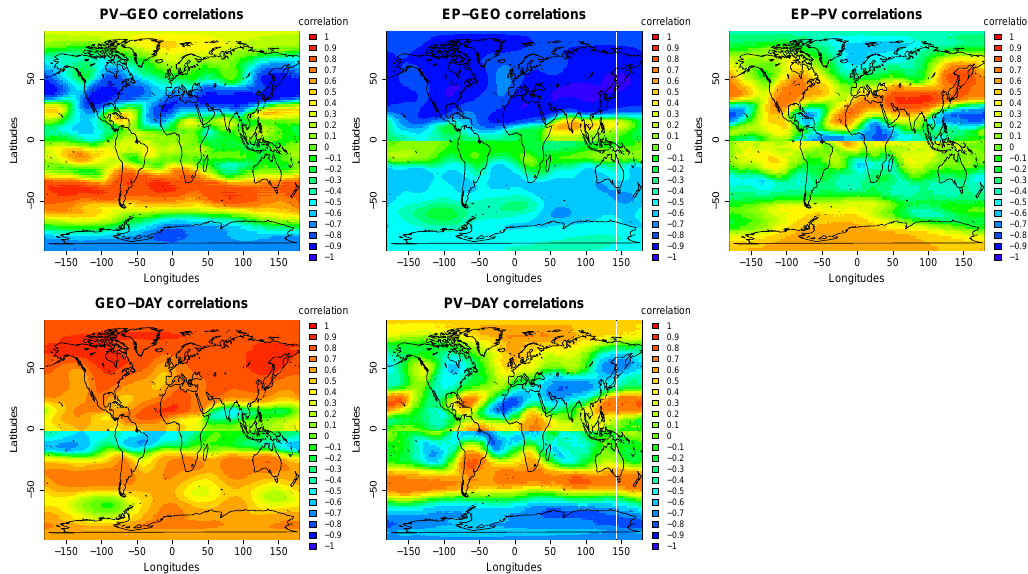
Figure 2. Correlation values between EP, GEO, PV and DAY. The correlations between EP and DAY are left out, since these values are nearly constant throughout both hemispheres (0.17 in the Southern Hemisphere (SH) and − 0.69 in the Northern Hemisphere